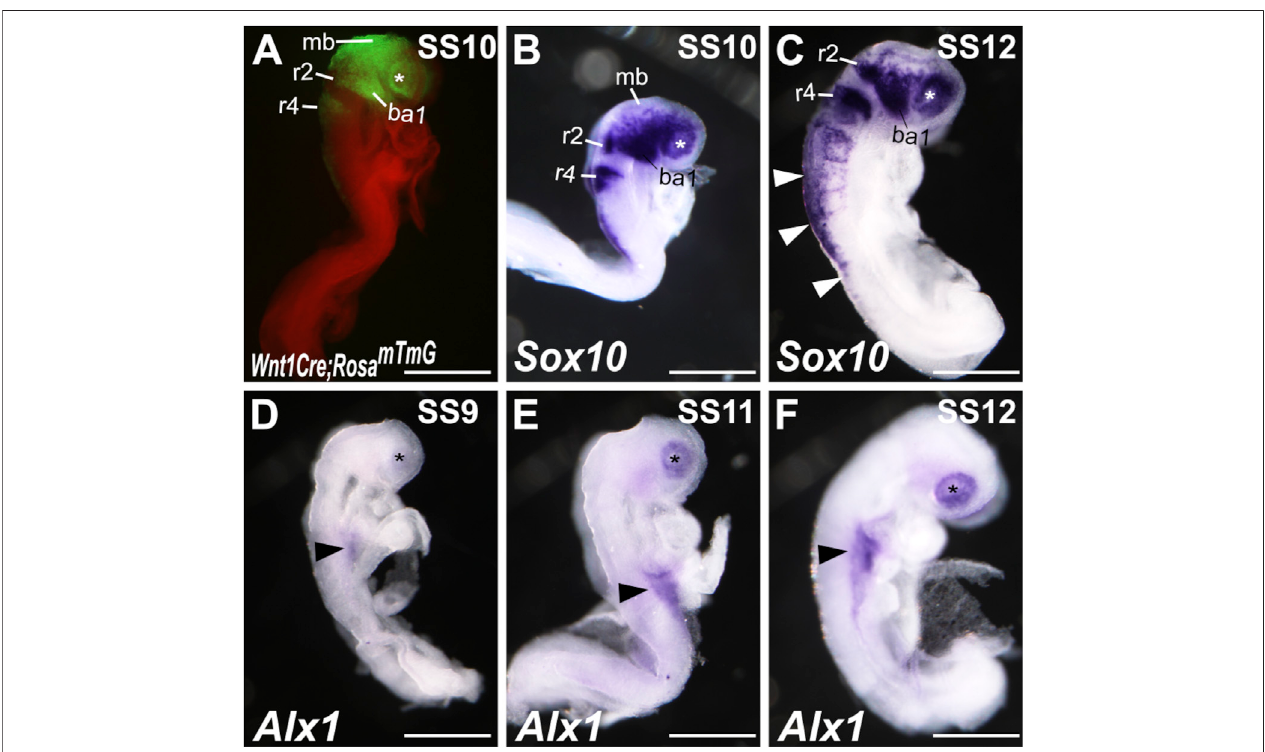
FIGURE 3 | Alx1 expression during early craniofacial development. (A) Lateral view of a Wnt1-Cre;Rosa26 mTmG embryo at somite stage (SS)10 showing GFP (green) labeled dorsal midbrain neuroepithelium and cranial neural crest cells. (B, C) Lateral views of wildtype SS10 (B) and SS12 (C) embryos showing the patterns of Sox10 mRNA expression detected by whole mount in situ hybridization (blue/purple color). White arrowheads in (C) point to the Sox10 expression in the trunk neural crest cells. (D – F) Lateral views of wildtype SS9 (D) , SS11 (E) , and SS12 (F) embryos showing the patterns of Alx1 mRNA expression detected by whole mount in situ hybridization (blue/purple color). The asterisk in A-F mark the location of the optic placode. Arrowheads in (D – F) point to the Alx1 expression in the lateral plate mesoderm. Scale bar, 500 μ m. ba1, branchial arch 1; mb, midbrain; r2, rhombomere 2; r4, rhombomere 4.